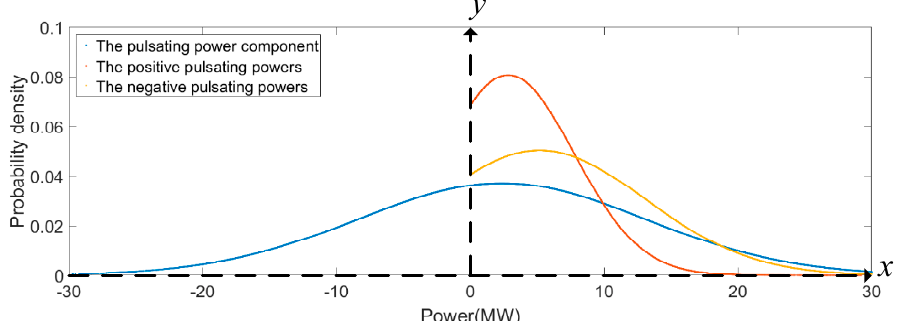
Figure 2. The probability density curves of the pulsating power components.